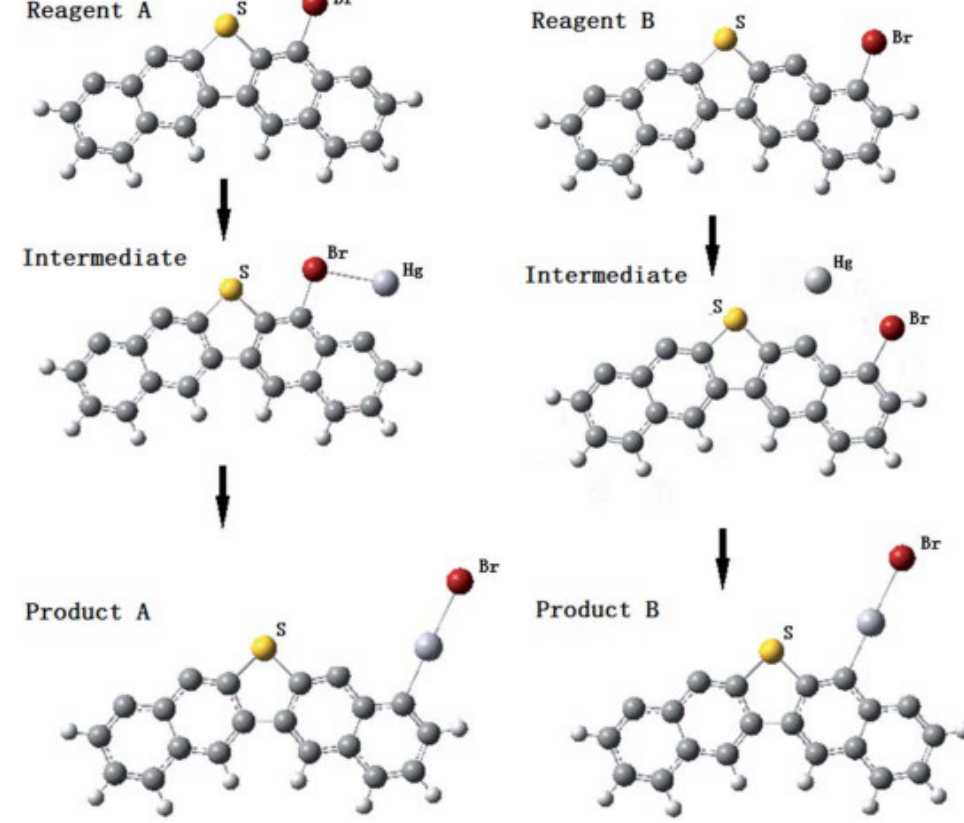
Figure 9. Hg 0 adsorption process on brominated petroleum coke model with one Br atom at different carbon sites near sulfur [55]. Reprinted/adapted with permission from Ref. [55]. 2021, RSC